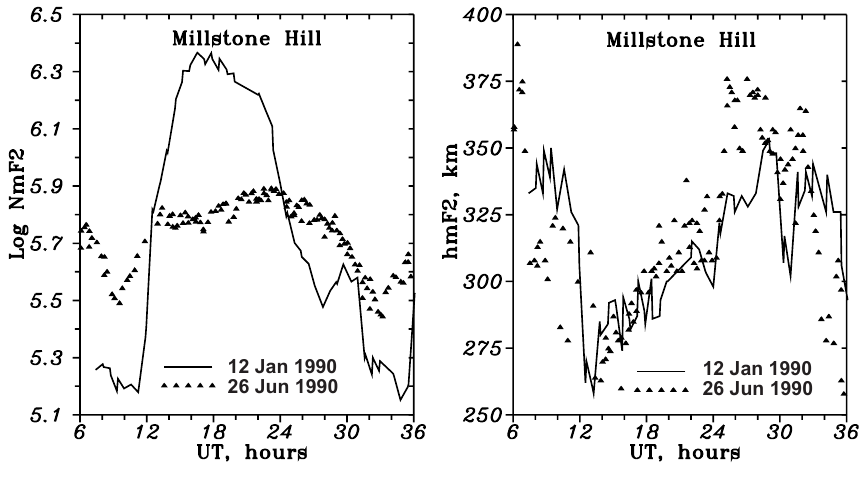
Table 7. Calculated thermospheric parameters at EISCAT com- pared with MSIS-83 model predictions (second line) at 300